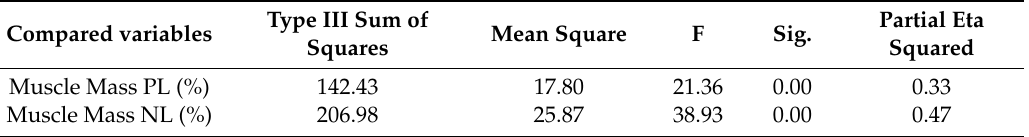
Figure 4. Di ff erences in fat-free mass among di ff erent age groups. Figure 4. Differences in fat-free mass among different age groups.